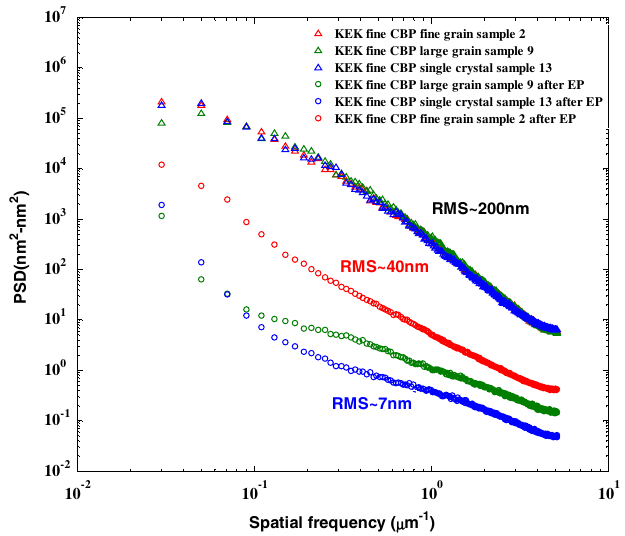
FIG. 8. (Color) The PSD of fine CBP polycrystalline, large gain and single crystal Nb samples after 30 (cid:3) m removal by EP at 30 (cid:5) 1 (cid:1) C with 14 V applied cell